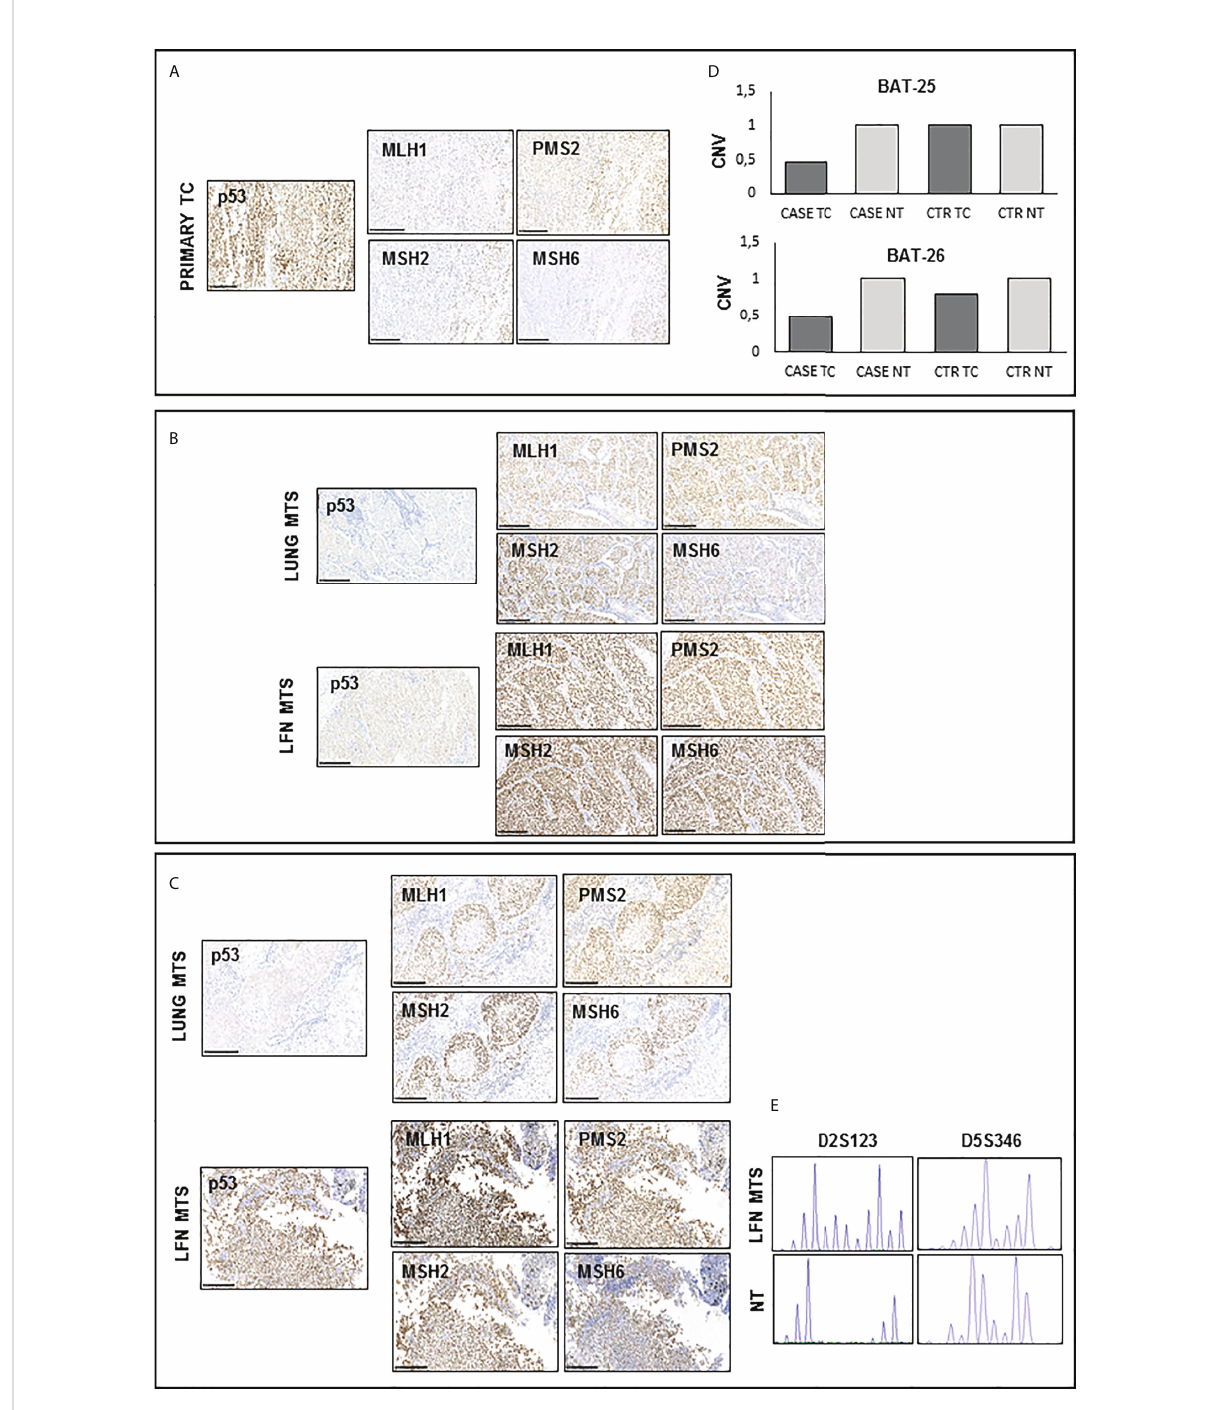
FIGURE 4 Immunohistochemistry for p53 and DNA mismatch repair (MMR) proteins and microsatellite instability (MSI) detection in available samples before and after Sorafenib treatment (A, C, D) A positive nuclear staining was observed for MHL1, MSH2, MSH6, and PMS2 proteins in all analyzed tissues samples. However, primary TC shows light staining and subclonal loss of expression in all MMR proteins. (B) CNV analysis shows the presence of a LOH for both BAT-25 and BAT-26 loci in the primary TC of our patient. (E) Peak analysis of D2S123 and D5S346 loci, performed using Genemapper 5 software, is clearly differently shaped in the lymph node obtained after Sorafenib treatment with respect to those of and contralateral normal thyroid tissue DNA, indicating a high microsatellite instability. TC, thyroid cancer; MTS, metastasis; NT, normal thyroid; CNV, copy number